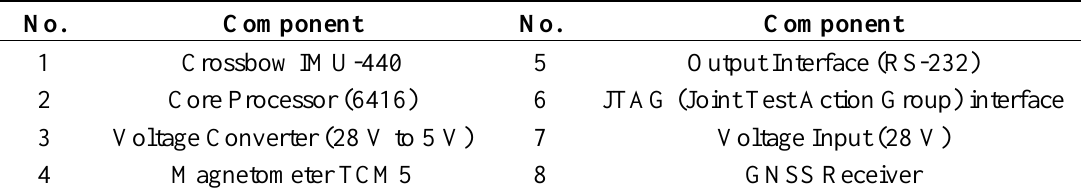
Figure 5. System constitution. Table 1. System